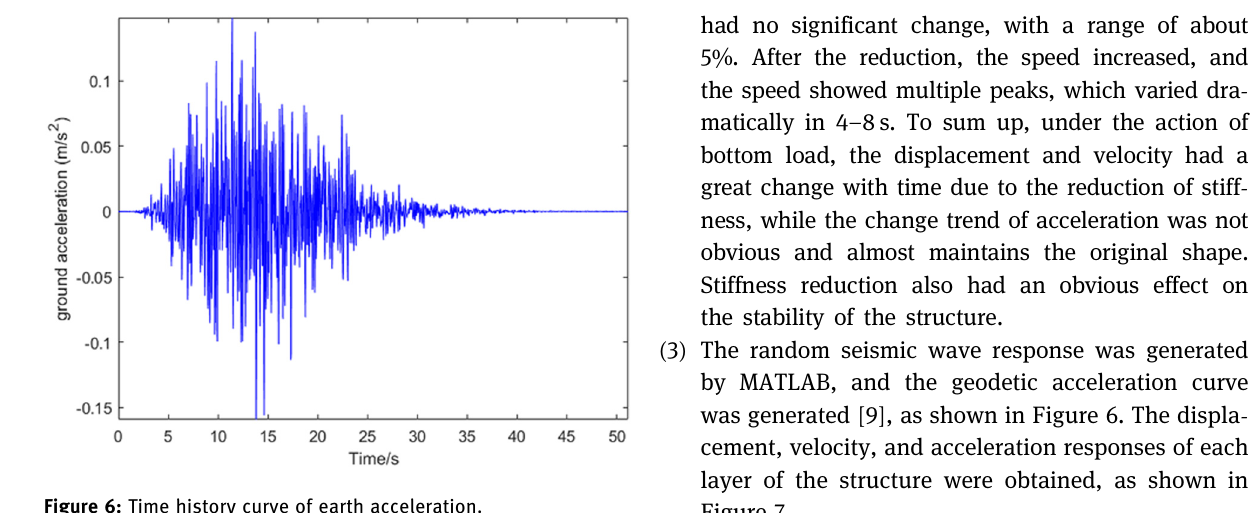
Figure 7. Figure 6: Time history curve of earth acceleration.